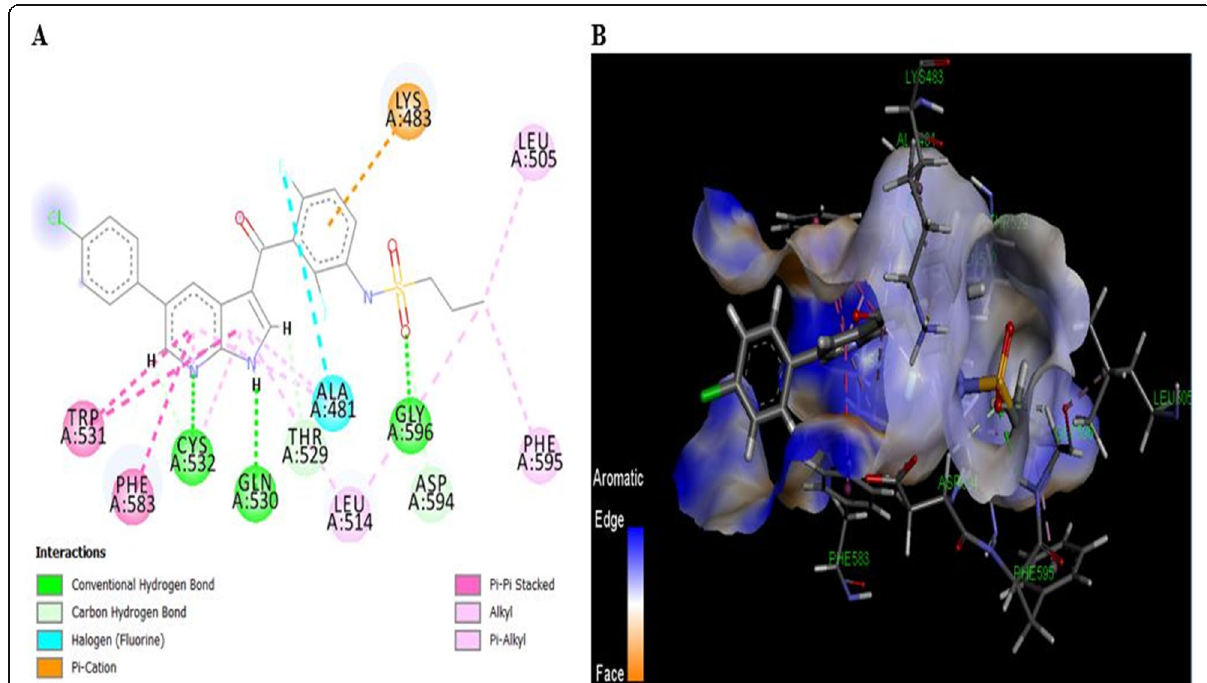
Fig. 6 a 2D diagram for the interaction of vem with V600E-BRAF. b 3D diagram of vem in the binding site of V600E-BRAF